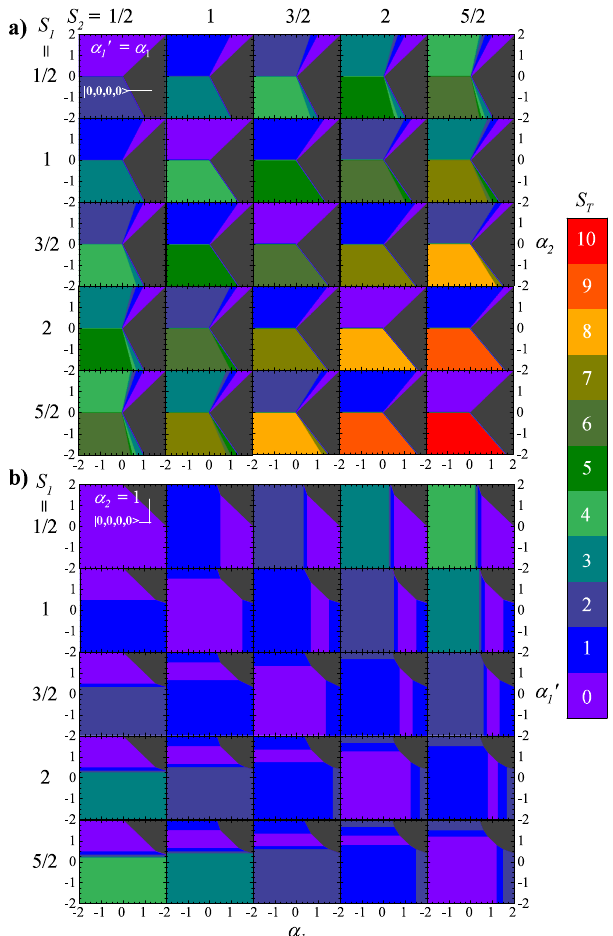
Figure 2. The ground state energy levels as functions of alpha parameters zero-field and J = 1. S 1 and S 2 denote the spins of the atoms making up S d 1 and S d 2 , respectively. The scale on the right side of the figure denotes the total spin of the system, S T , and relates a particular value to a color in the ground-state energy diagrams. Energy increases from a low value of S T to a higher value. = α ( a ) The ground-state energy map for energy as a function of α (cid:48) 1 and α 2 ; ( b ) The ground-state 1 energy map for energy as a function of α 1 and α (cid:48) , where α 2 = 1. The restriction of α 2 ’s value limits 1 the attainable S T , max state through transitions. The gray areas in ( a , b ) denote the | 0,0,0,0 > state ( | S T , S d 1 , S d 2 , m z >